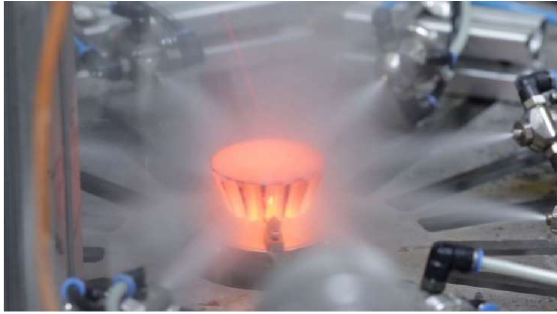
Figure 5. Quenching of a rotating bevel gear in an air-water spray.